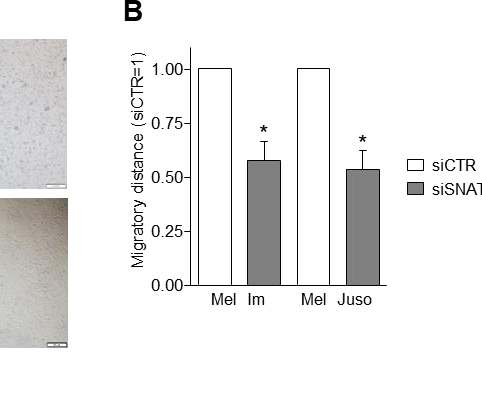
Figure 4. Effects of SNAT1 downregulation on migratory and invasive potential of melanoma cells. ( A , B ) Analysis of cell migration using scratch wound healing assay of Mel Im and Mel Juso cell lines after siSNAT1 downregulation when compared to siCTR cells. ( A ) Representative images of cell